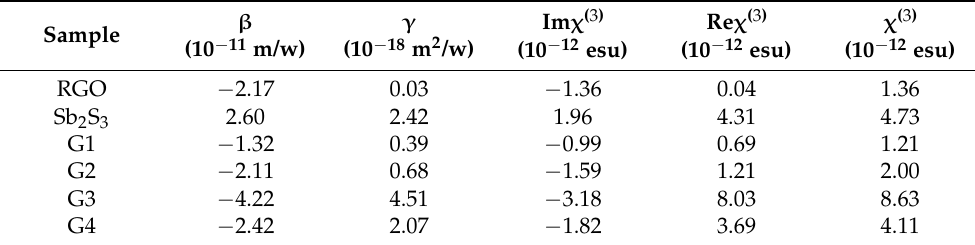
Table 1. The NLO parameters of the samples.